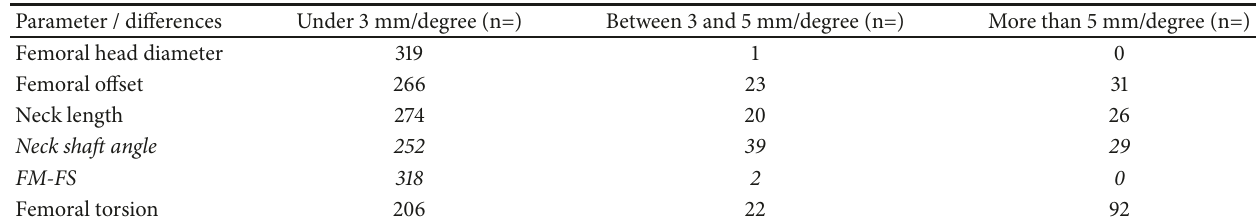
Table 4: Bilateral asymmetry. The presence of differences between patients limb sides are presented here with individuals divided into three groups based on the magnitude of difference between the two sides, irrespective of side. Parameter / differences Under 3 mm/degree (n=) Between 3 and 5 mm/degree (n=) More than 5 mm/degree (n=) Femoral head diameter 319 Femoral